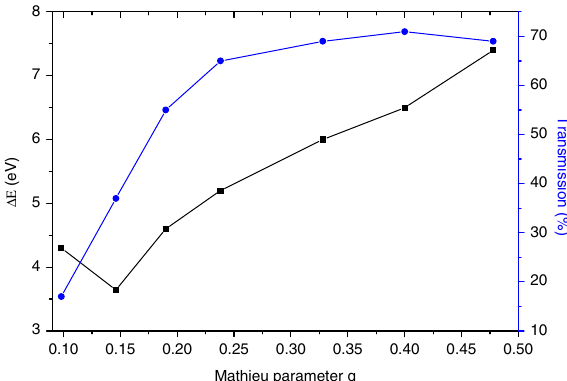
FIG. 13. The rf voltage amplitude effect on the longitudinal energy spread: variation of both the energy spread and its corresponding transmission as a function of the Mathieu param- eter q